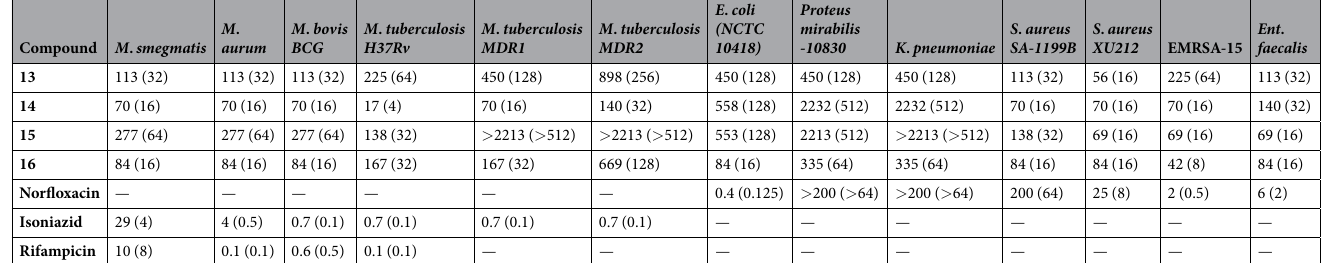
Table 1. Minimum Inhibitory Concentrations (MIC) in µ M (mg L − 1 ) of the synthesized compounds ( 13 – 16 ) against non-pathogenic mycobacteria and pathogenic multidrug-resistant clinical isolates of Mycobacterium tuberculosis , as well as Gram-positive and Gram-negative